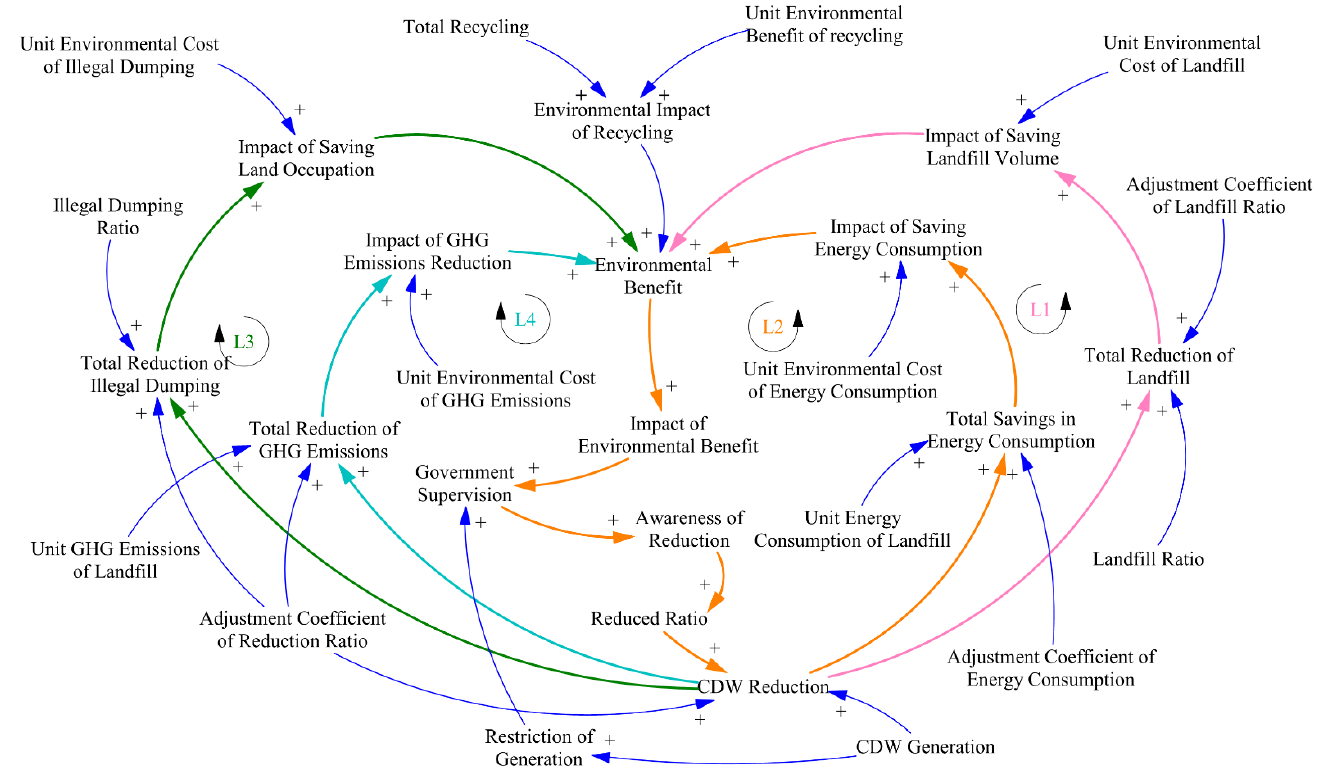
Figure 2. Causal relationship of environmental benefit subsystem.